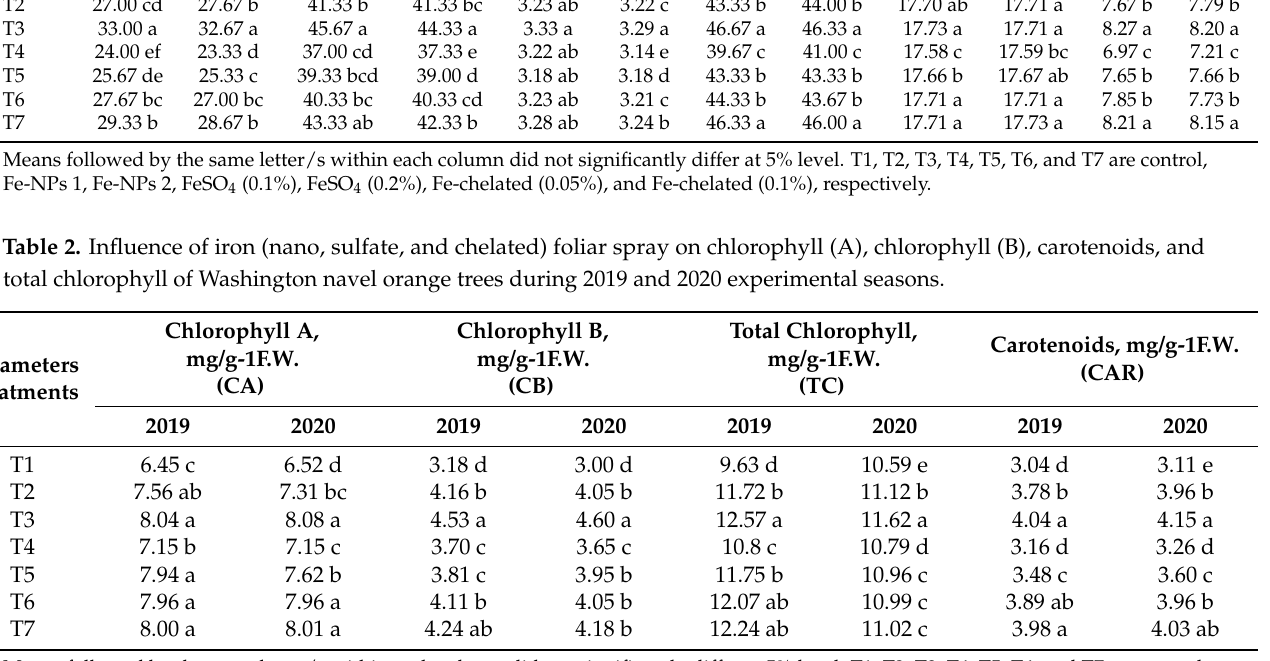
Table 1. Influence of iron (nano, sulfate, and chelated) foliar spray on some vegetative growth parameters of Washington navel orange trees during 2019 and 2020 experimental seasons. No. of New Shoot Length, cm Shoot Diameter, Parameters Shoots (NS) (SL) mm (SD) Treatments